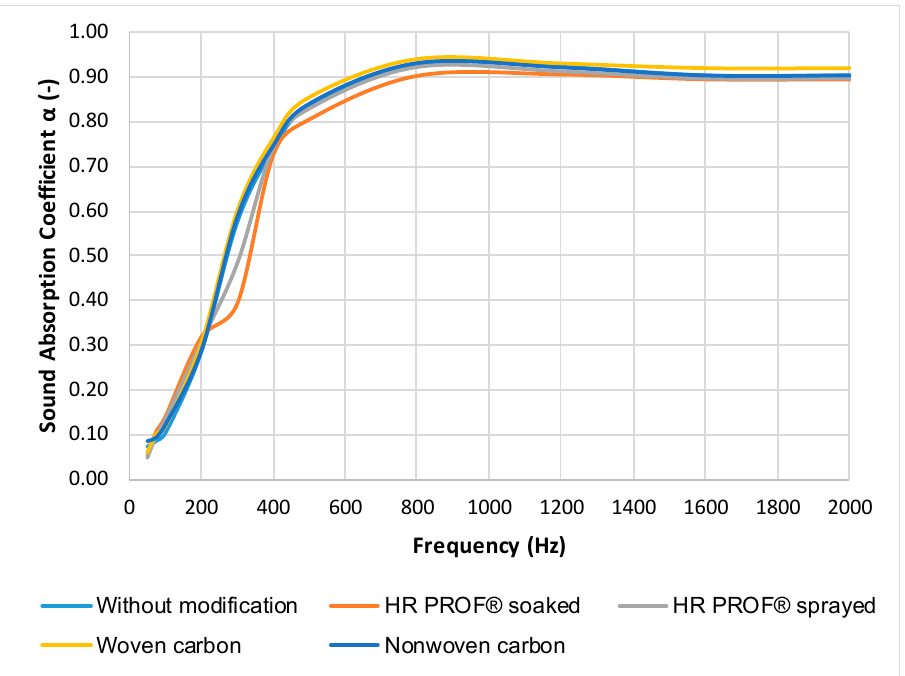
Figure 7. Frequency dependence of sound absorption coefficient α (-) of Senizol AT XX2 TL60 before and after application of HR Prof, woven and non-woven carbon foil.